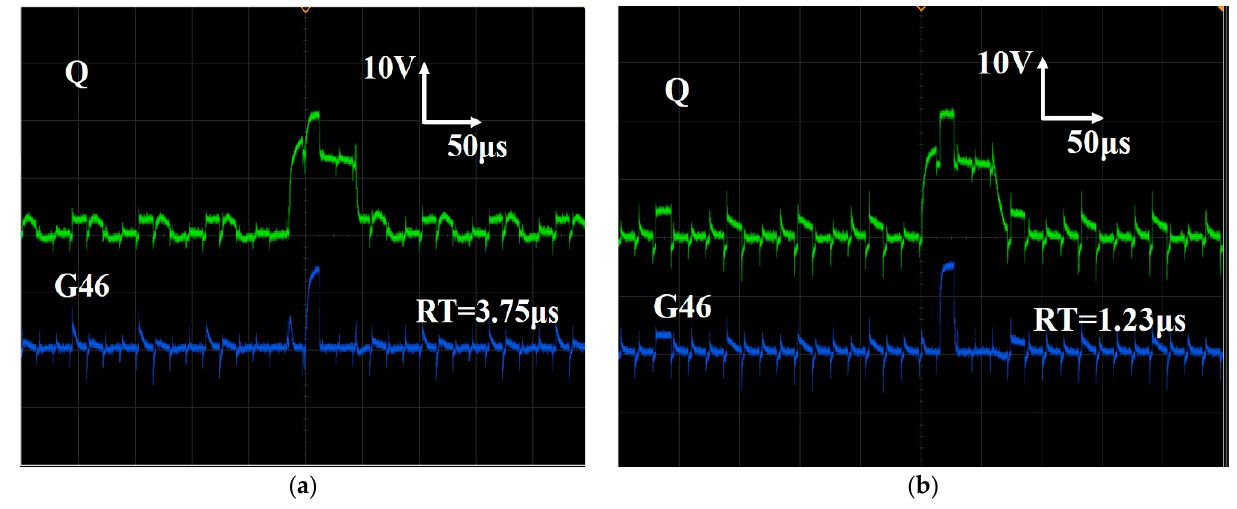
Figure 8. ( a ) The output signal generated by the SR circuit without dual-gate TFTs; ( b ) the output signal generated by the SR circuit with dual-gate TFTs.